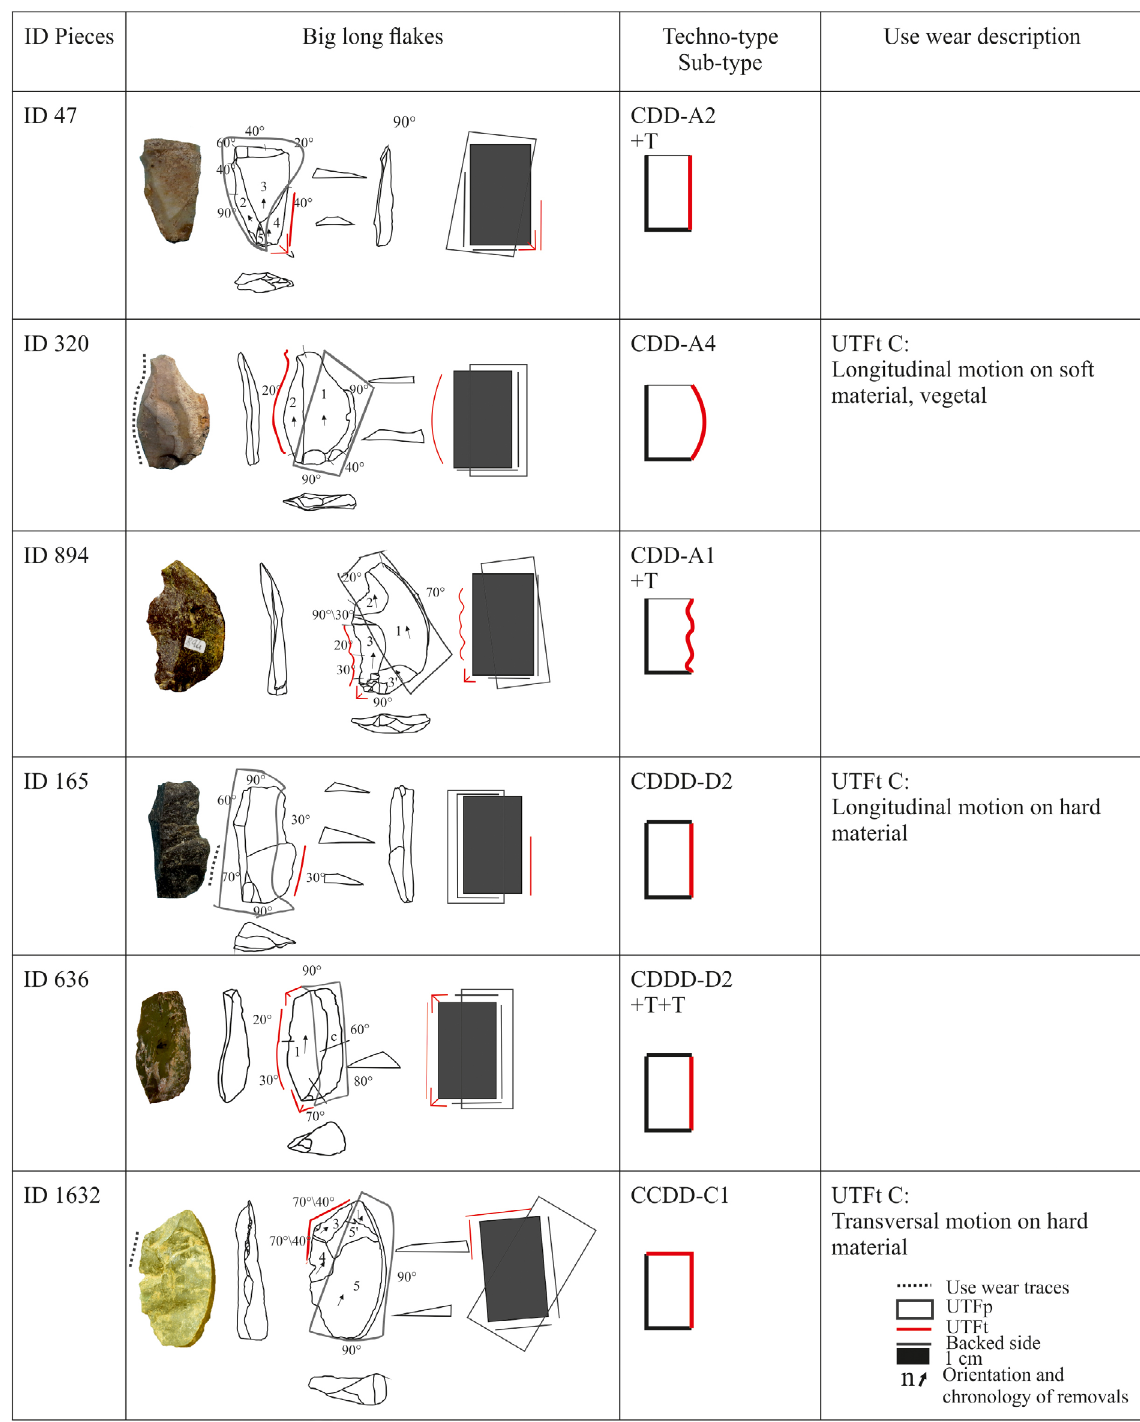
Figure 11. Techno-functional analysis and description of use wear traces of the big long